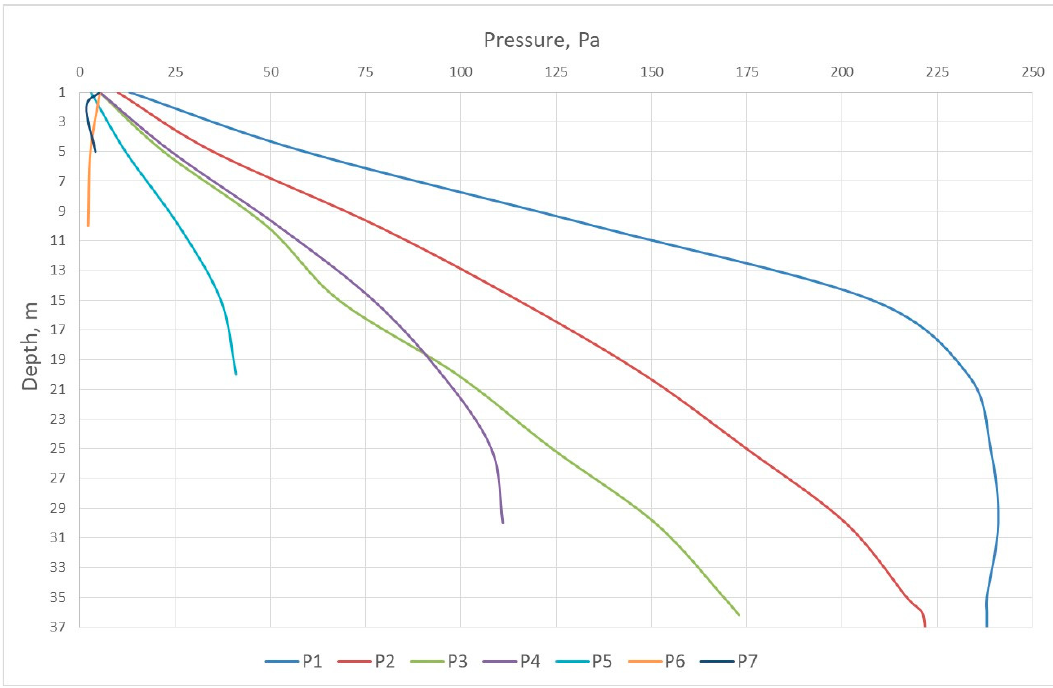
Figure 5. Vertical profile of the hydroacoustic pressure distribution at a frequency of 22 Hz at stations P1–P7.